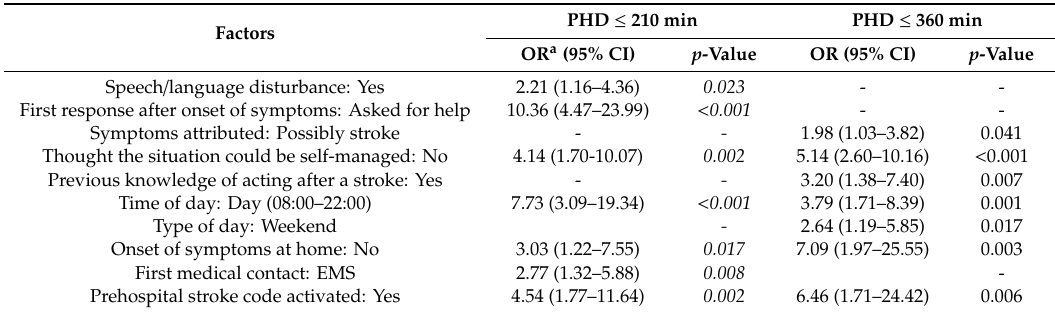
Table 6. Multivariable regression analysis of independent predictors of delay ≤ 210 min and ≤ 360 min from the symptom onset to hospital